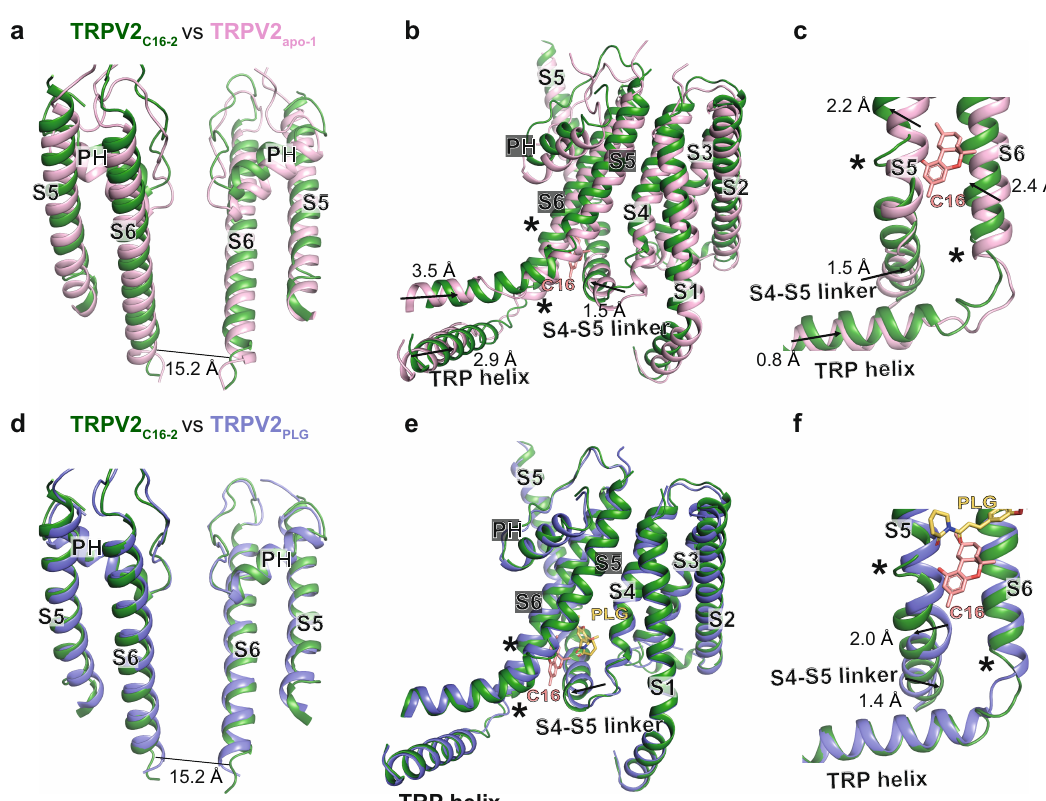
Fig. 7 | C16-induced conformational changes. Overlay of the ( a - c ) TRPV2 C16-2 (darkgreen)andTRPV2 apo-1 (PDB-ID:6U84,pink)and( d - f )TRPV2 C16-2 (darkgreen) and TRPV2 PLG (PDB-ID: 6WKN, purple) structures based on global tetramer align- ment. a - c Membrane viewsofTRPV2 C16-2 and TRPV2 apo-1 showing ( a )twoopposite S5-PH-S6units,( b )asinglesubunit(S1-S5)andanadjacentsubunit(showingS5-PH-